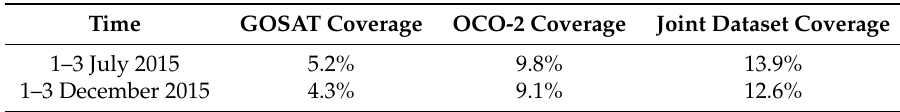
Figure 3. Map of the data coverages of GOSAT and OCO-2 within the first three days in December 2015. Table 1. Fractions of local grid coverage by GOSAT, OCO-2 and the joint dataset at a resolution of 2 ◦ latitude × 2.5 ◦